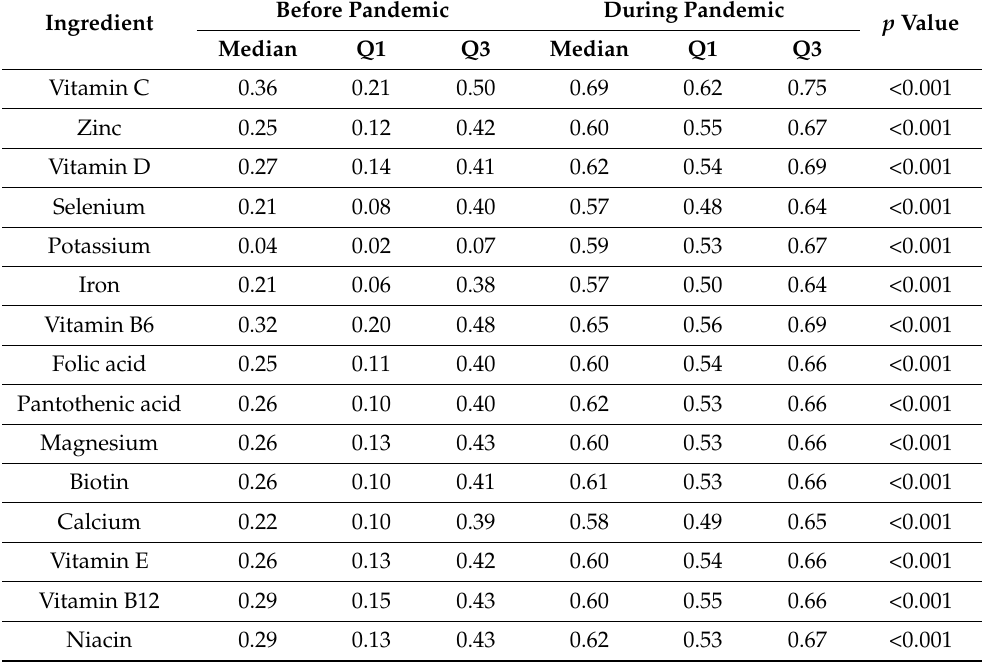
Table A1. Comparison of the percent of products containing individual ingredients from the period before the pandemic was announced and from the period after its announcement using the U Manna-Whitney test (with continuity correction).